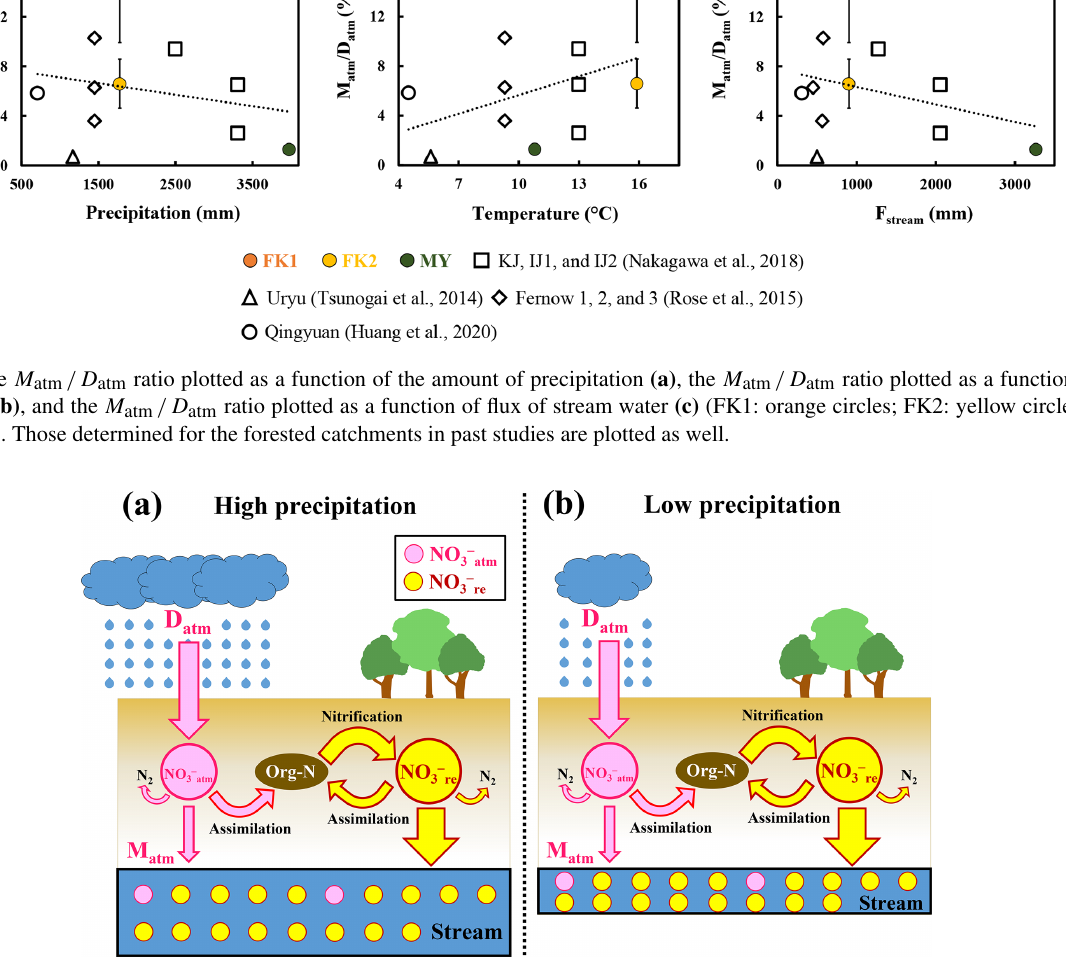
Figure 5. Schematic diagram showing the biogeochemical processing of nitrate in forested catchments under high precipitation (a) and low precipitation (b) , where NO − (unprocessed atmospheric nitrate) is represented by pink circles, NO − 3 atm (remineralized nitrate) by yellow arrows (modified after Nakagawa et al., 2018). Although NO − by pink arrows, and those of NO − 3 re 3 atm the deposition rates of NO − ( D atm ) and the biogeochemical reaction rates between (a) and (b) are the same, we can expect high [NO − 3 atm in (b) . On the other hand, the M atm /D atm ratio between (a) and (b) are the same.